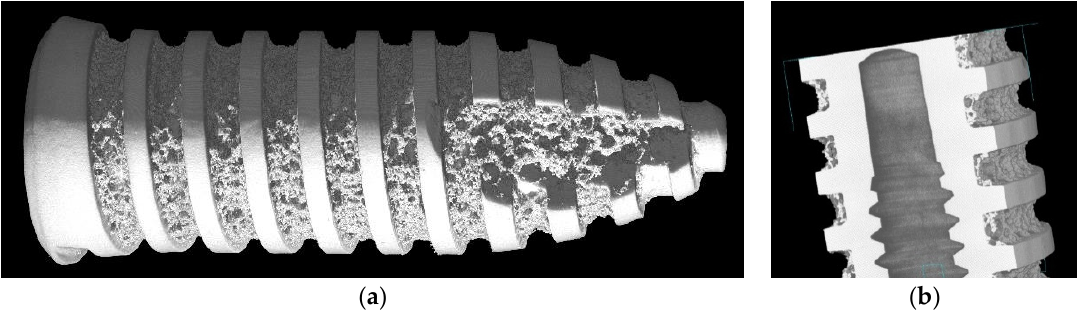
Figure 14. ( a ) Tomography of a Ti ‐ based porous dental implant for osseointegration improvement; and ( b ) detail of the inner structure and porous surface (courtesy of Louis ‐ Philippe Lefebvre).